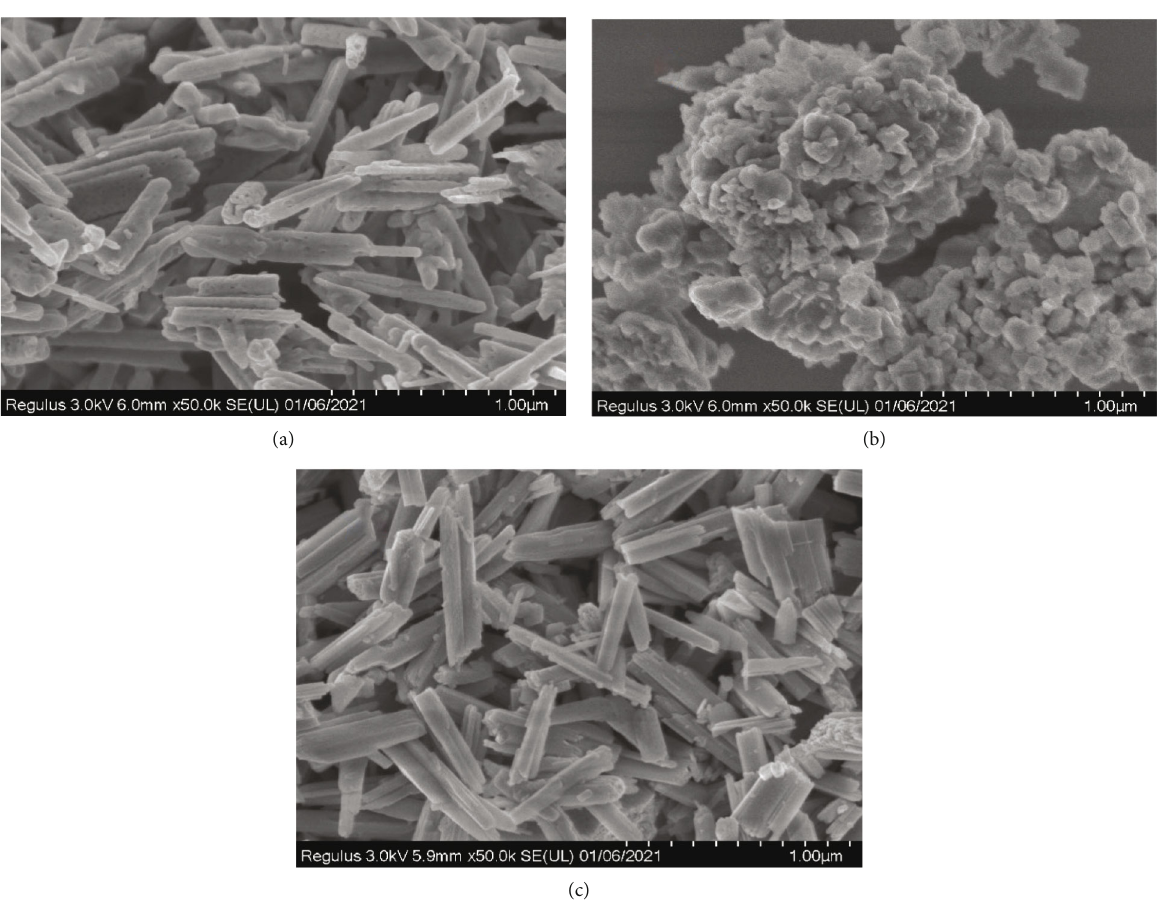
Figure 4: SEM images of (a) α -Fe